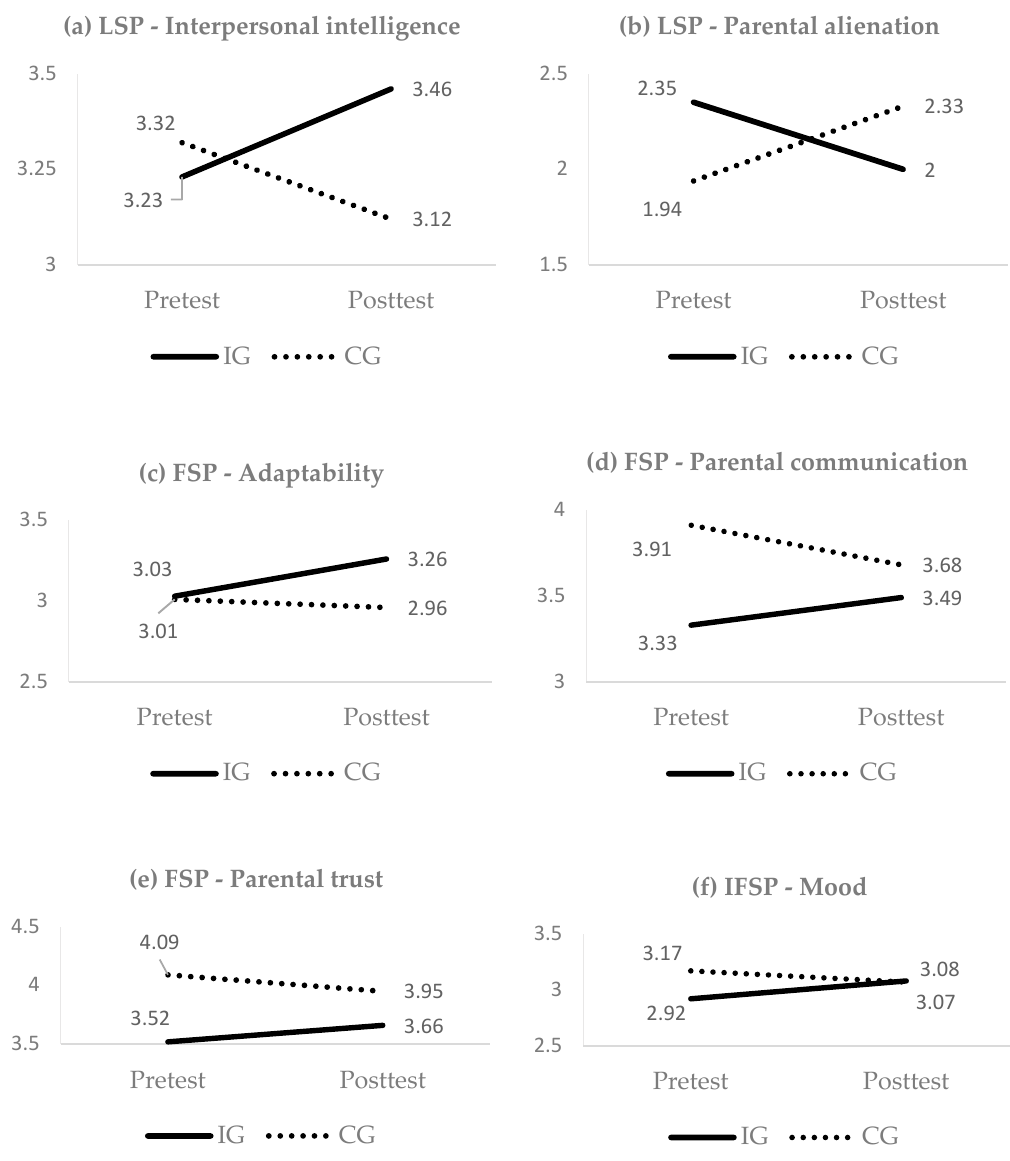
Figure 2. Significant interaction effects time*group (intervention vs. control). ( a ) LSP—Interpersonal